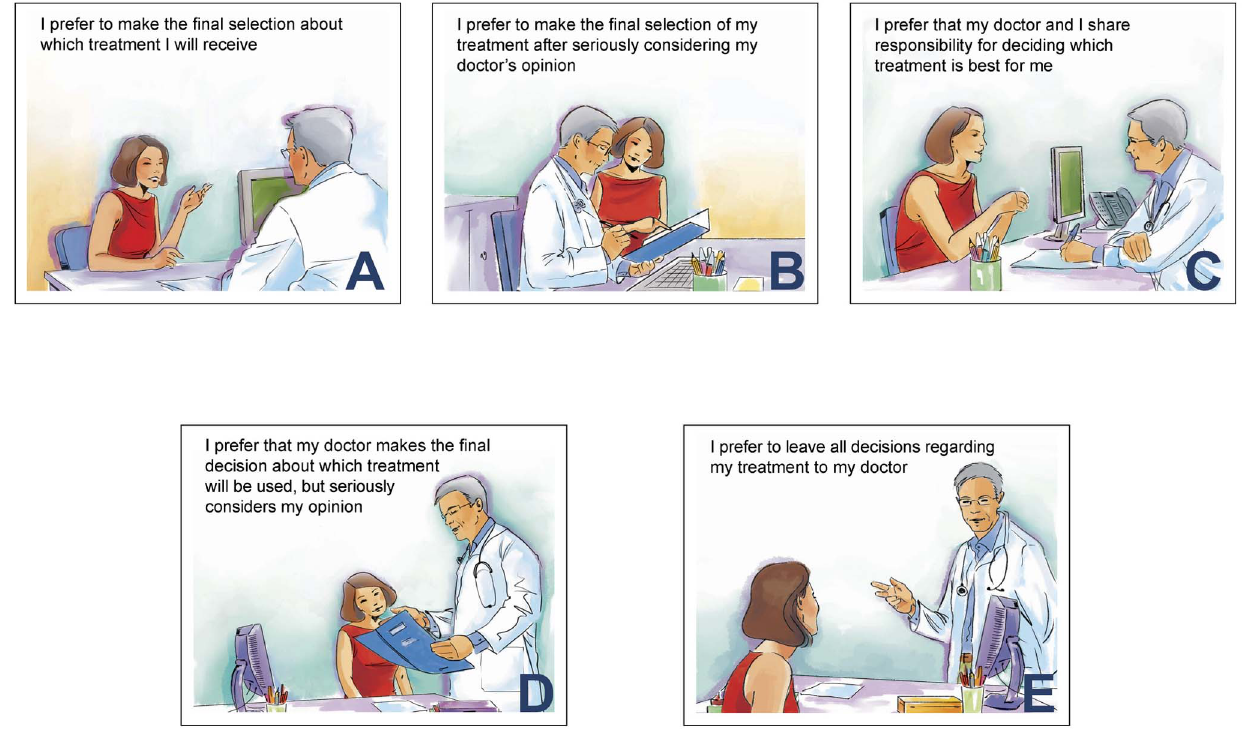
Figure 1. The five CPS cards with new cartoons.